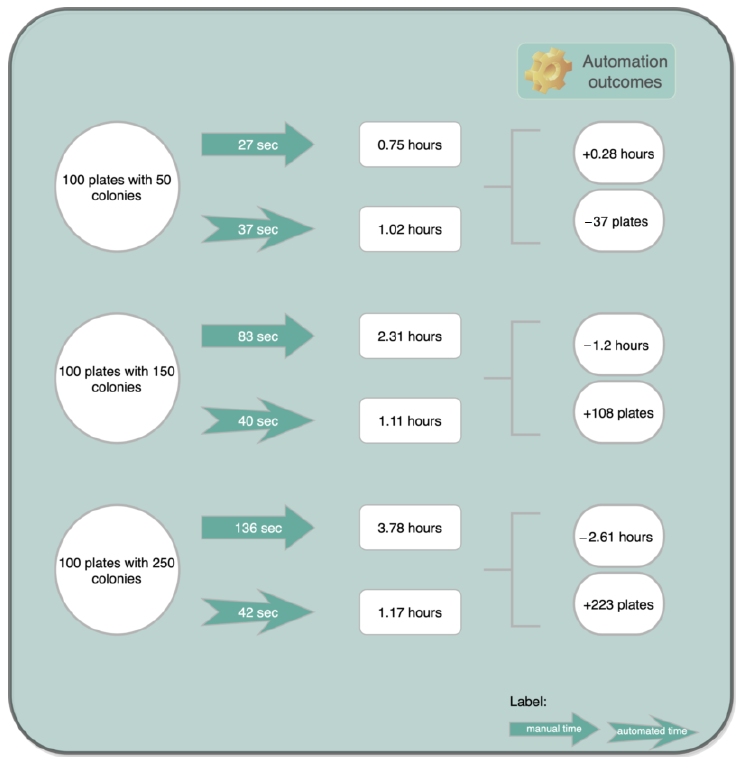
Figure 22. Exercise of time management with an automated enumeration